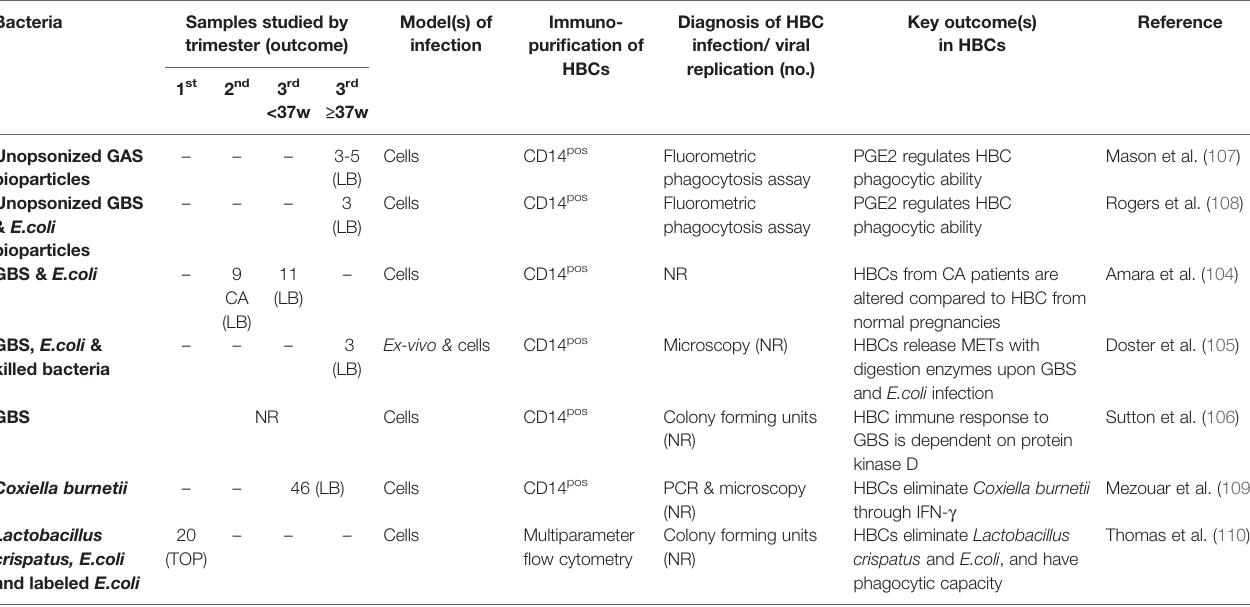
TABLE 4 | Hofbauer cells in in vitro studies of bacterial infection.